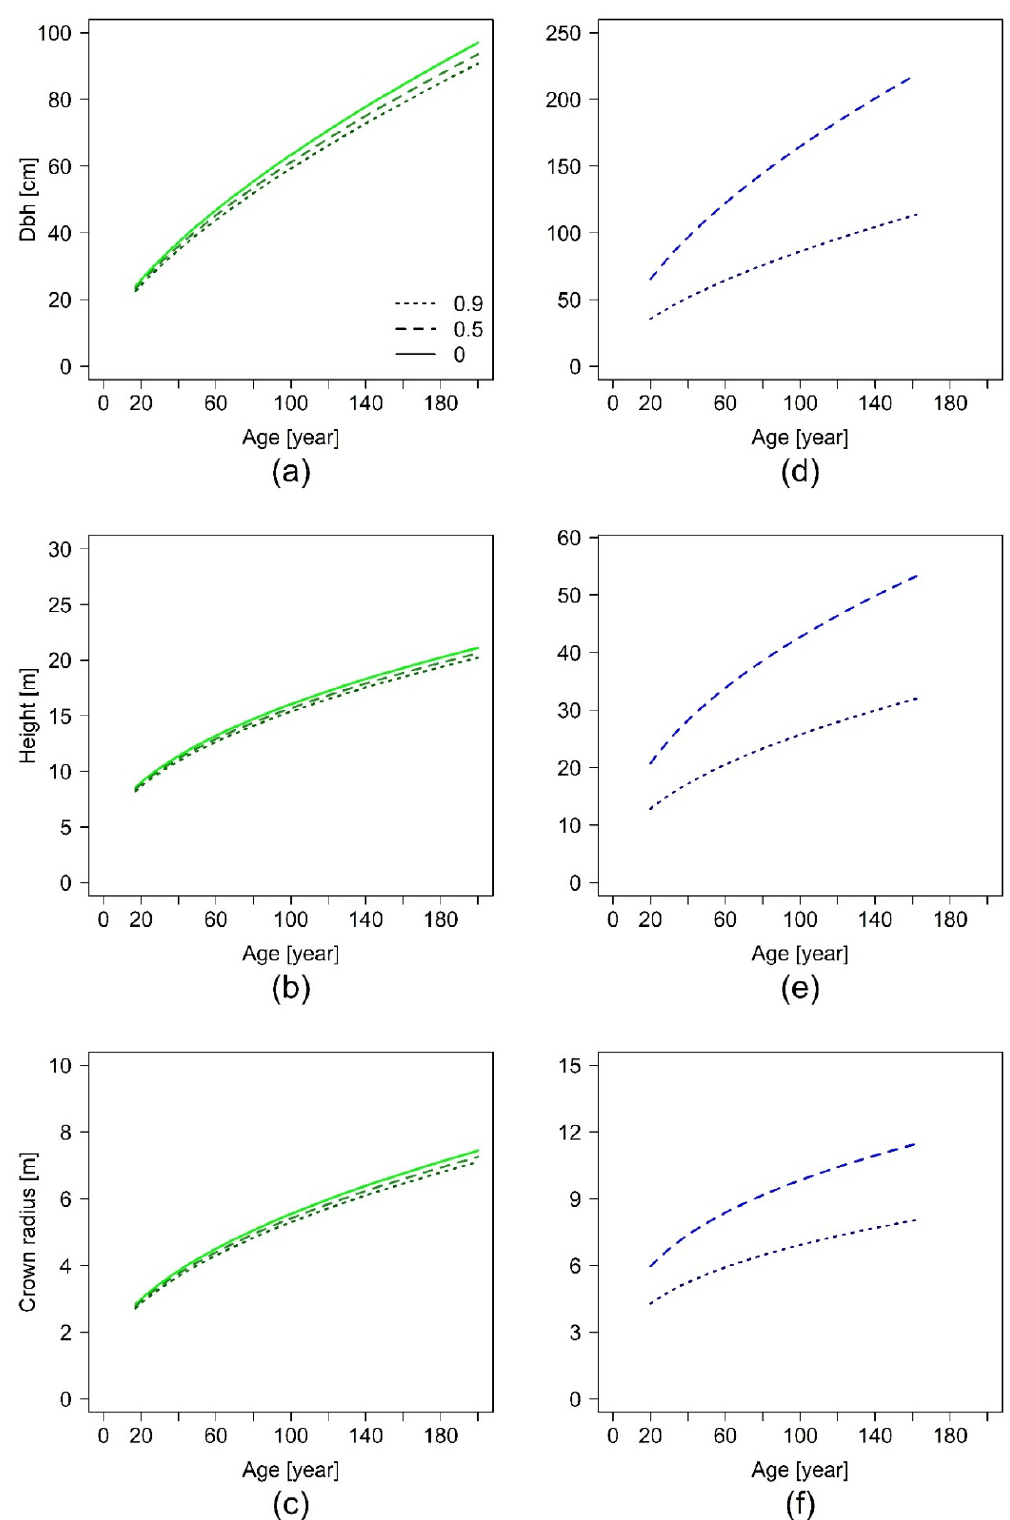
Figure 2. Effect of SCON on allometric growth relationships for diameter at breast height , tree height, and crown radius depending on age for the species Aesculus hippocastanum (panels a – c ) and for Khaya senegalensis (panels d – f ); solid line: no limitation, dashed line: 50% limited, and dotted line: highly limited (90%).